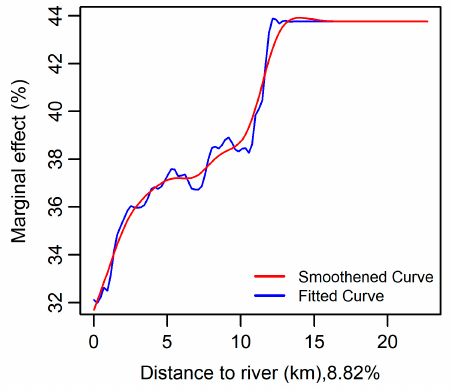
Figure 6. The relationships between water resources and RPI.